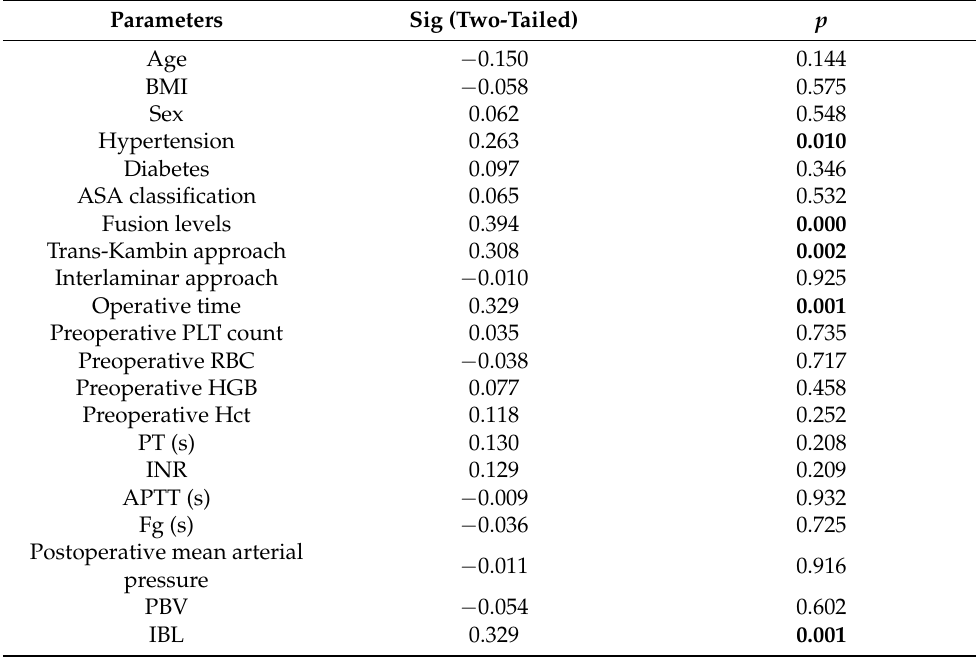
Table 3. Results of the Pearson or Spearman correlation analysis for HBL.